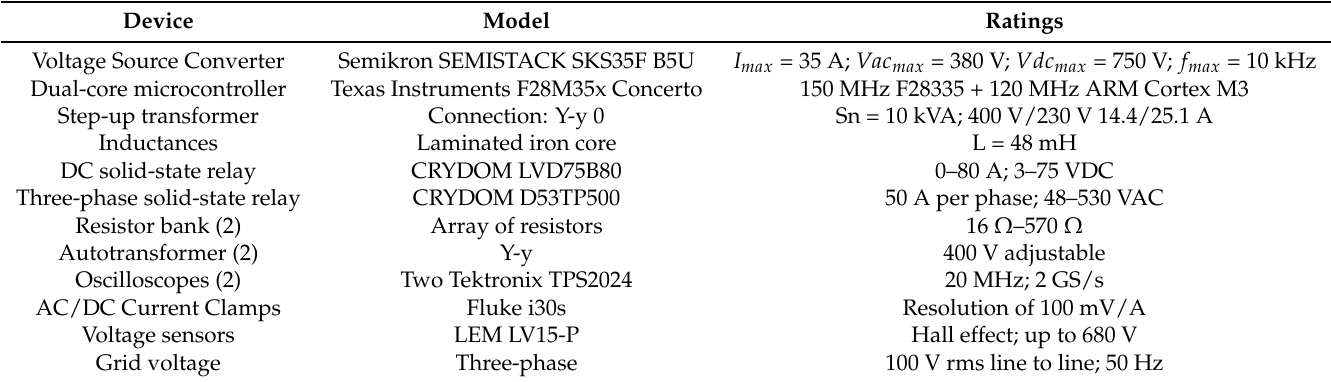
Table 1. List of devices and electrical components used in the experimental